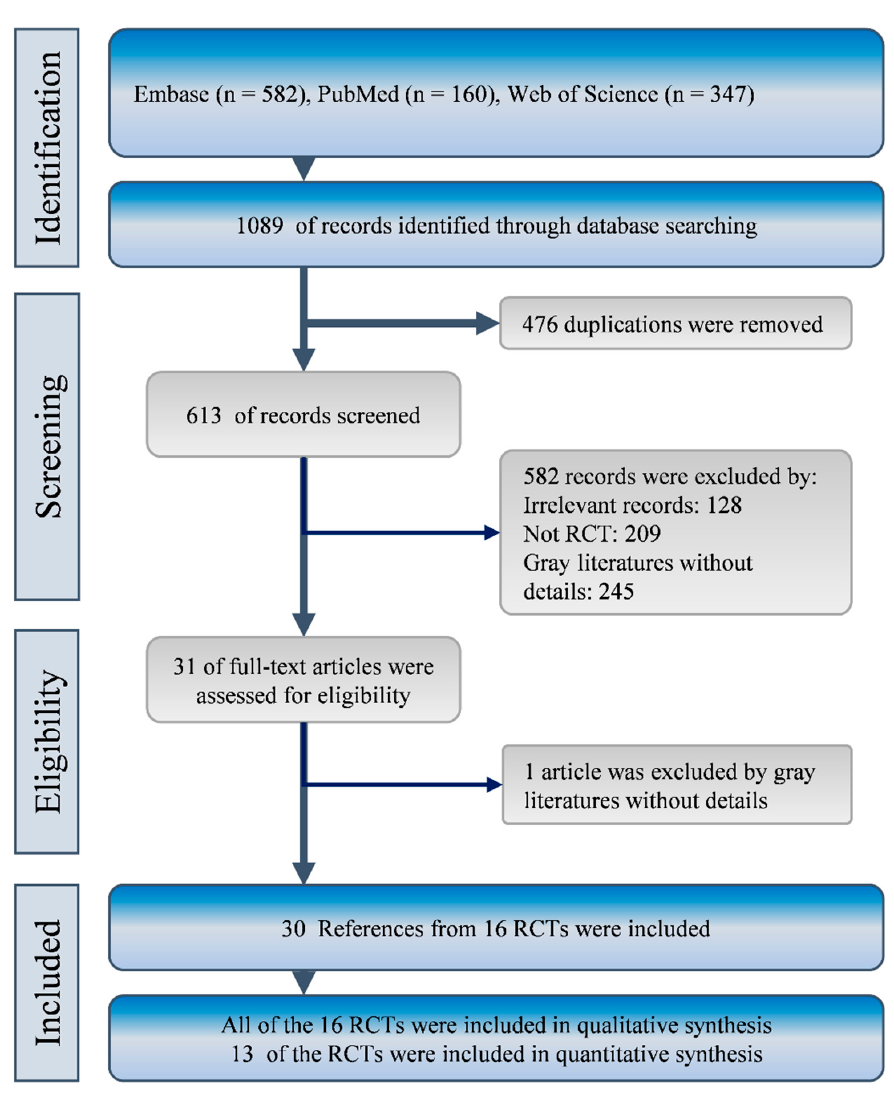
Figure 1. Flow diagram of study selection.